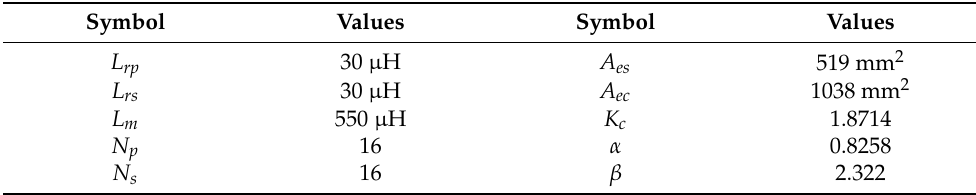
Table 1. Parameters of the CLLC resonant converter and the magnetic core.